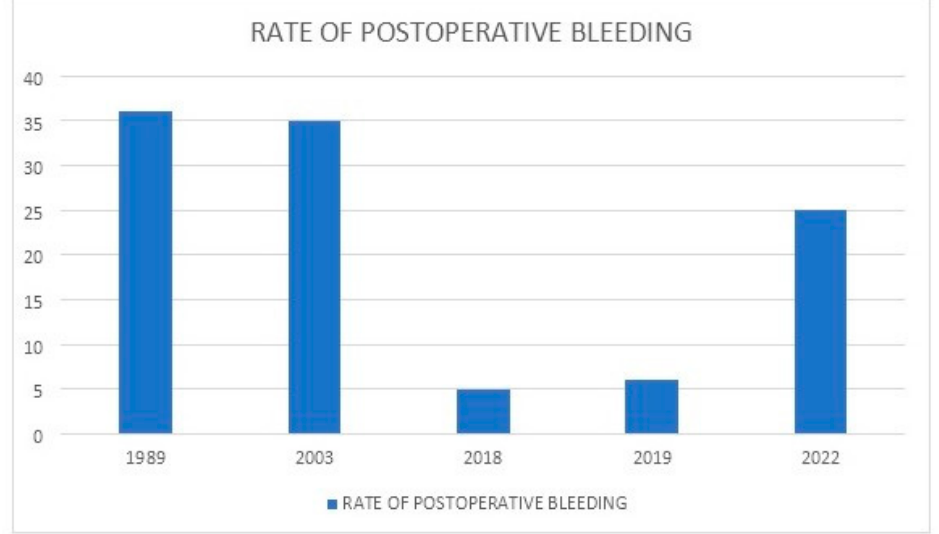
Figure 2. Rates of postoperative bleeding after total knee arthroplasty (TKA) in people with hemophilia (PWH) from 1989 to 2022.